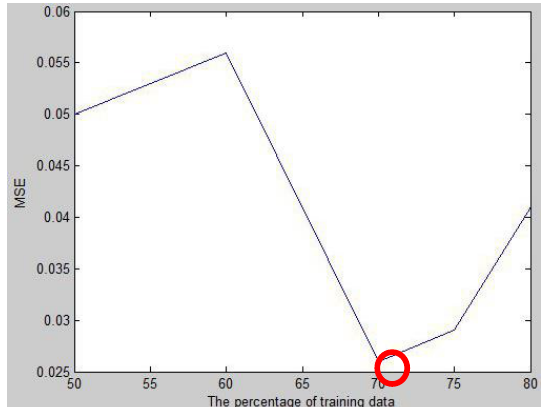
Figure 7. Evaluating the percentage of training data to